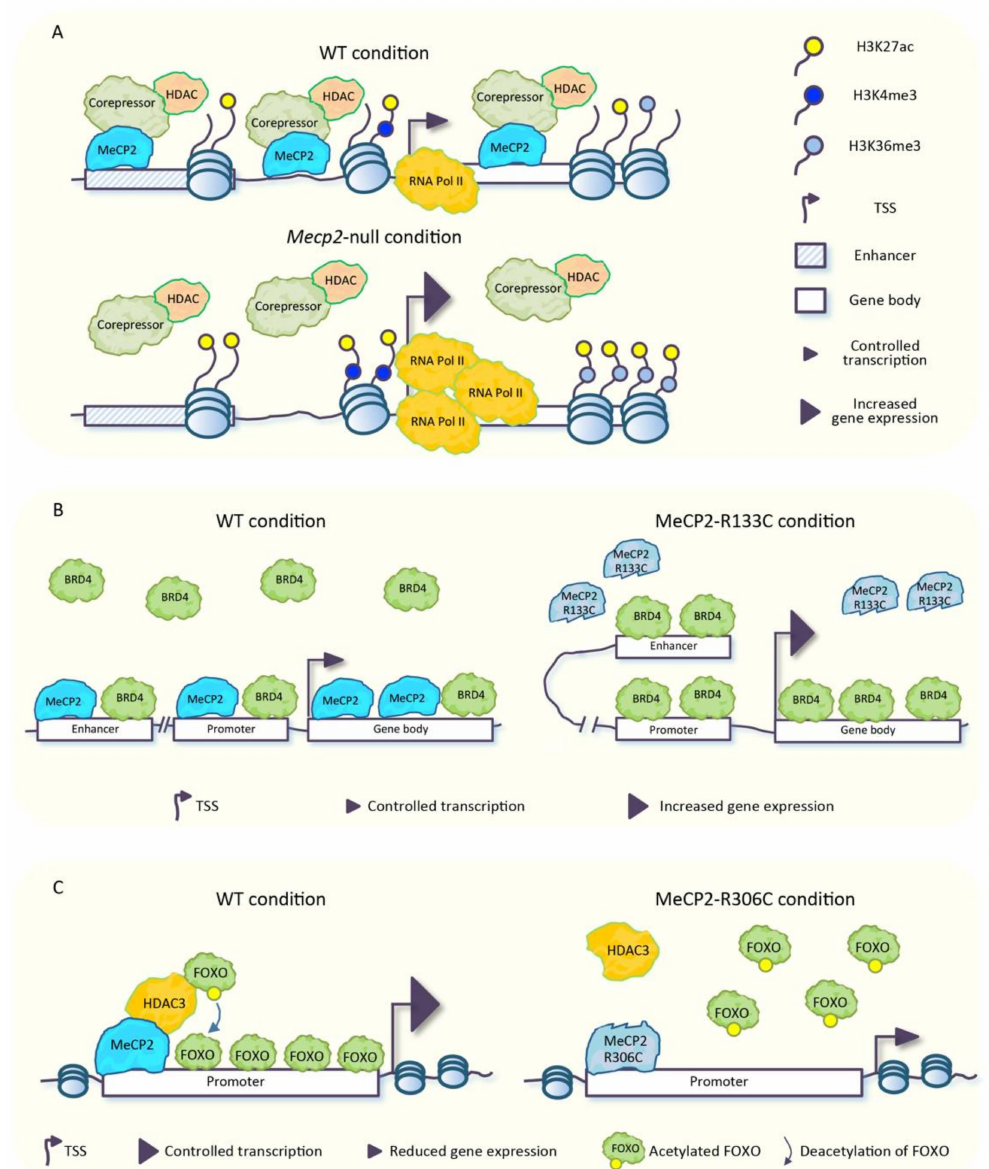
Figure 2. MeCP2 dysfunctions lead to uncontrolled distribution of epigenetic factors and histone modifications. ( A ) In WT neurons, MeCP2 controls gene expression by recruiting complexes containing histone deacetylase activity, which survey the acetylation status of H3K27 across enhancers, TSS, and gene bodies (top). The absence of MeCP2 leads to the enhanced acetylation of H3K27 across regulatory regions and gene body and causes a higher accumulation of RNA pol II at TSS. These changes are accompanied by a higher enrichment of H3K4me3 at TSS and of H3K36me3 at gene bodies, which correlate with gene up-regulation (bottom) (adapted from [61,83]). ( B ) In WT interneurons, in basal physiological conditions, the binding of BRD4 across enhancers, promoters, and gene bodies is low (left); in MeCP2-R133C interneurons, the binding of BRD4 across gene bodies and regulatory regions increases. These changes parallel a higher frequency of enhancer/promoter interactions with the resulting gene up-regulation (adapted from [84,85]). ( C ) In physiological conditions, MeCP2 recruits HDAC3, which deacetylates FOXO transcription factors [86]. Once deacetylated, FOXO proteins bind DNA and activate transcription (left) [87,88]. In MeCP2-R306C neurons, the increased acetylation of FOXO proteins occurs, which leads to the reduced enrichment of these transcription factors to promoters. These events lead to gene down-regulation (right)